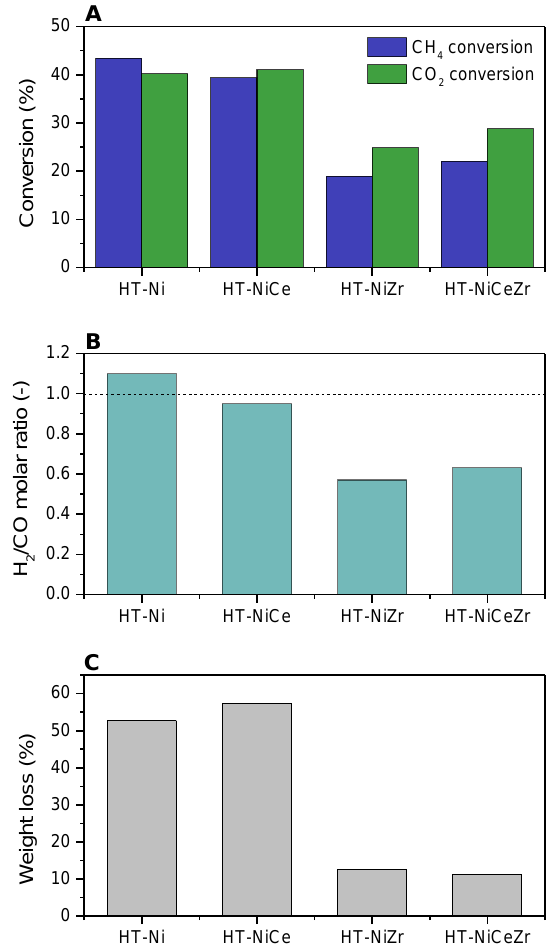
Figure 5. The results of DRM catalytic tests over Ce- and/or Zr-promoted catalysts: ( A ) CH 4 and CO 2 conversion ( B ) product distribution and ( C ) results of thermogravimetric measurements for spent catalysts. Adapted from [89].